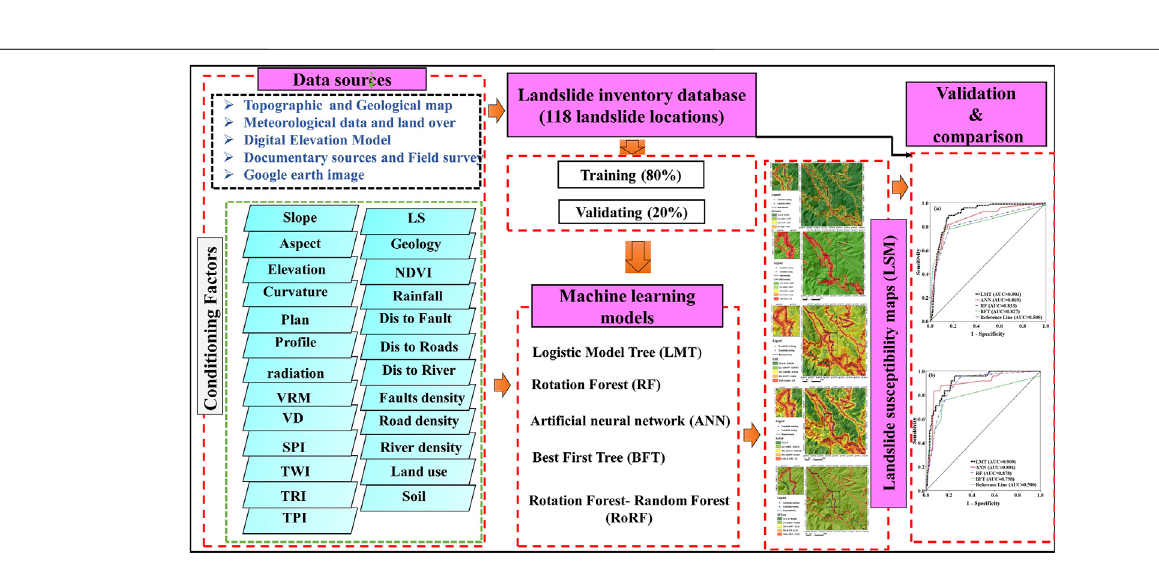
FIGURE 3 | Flowchart of the